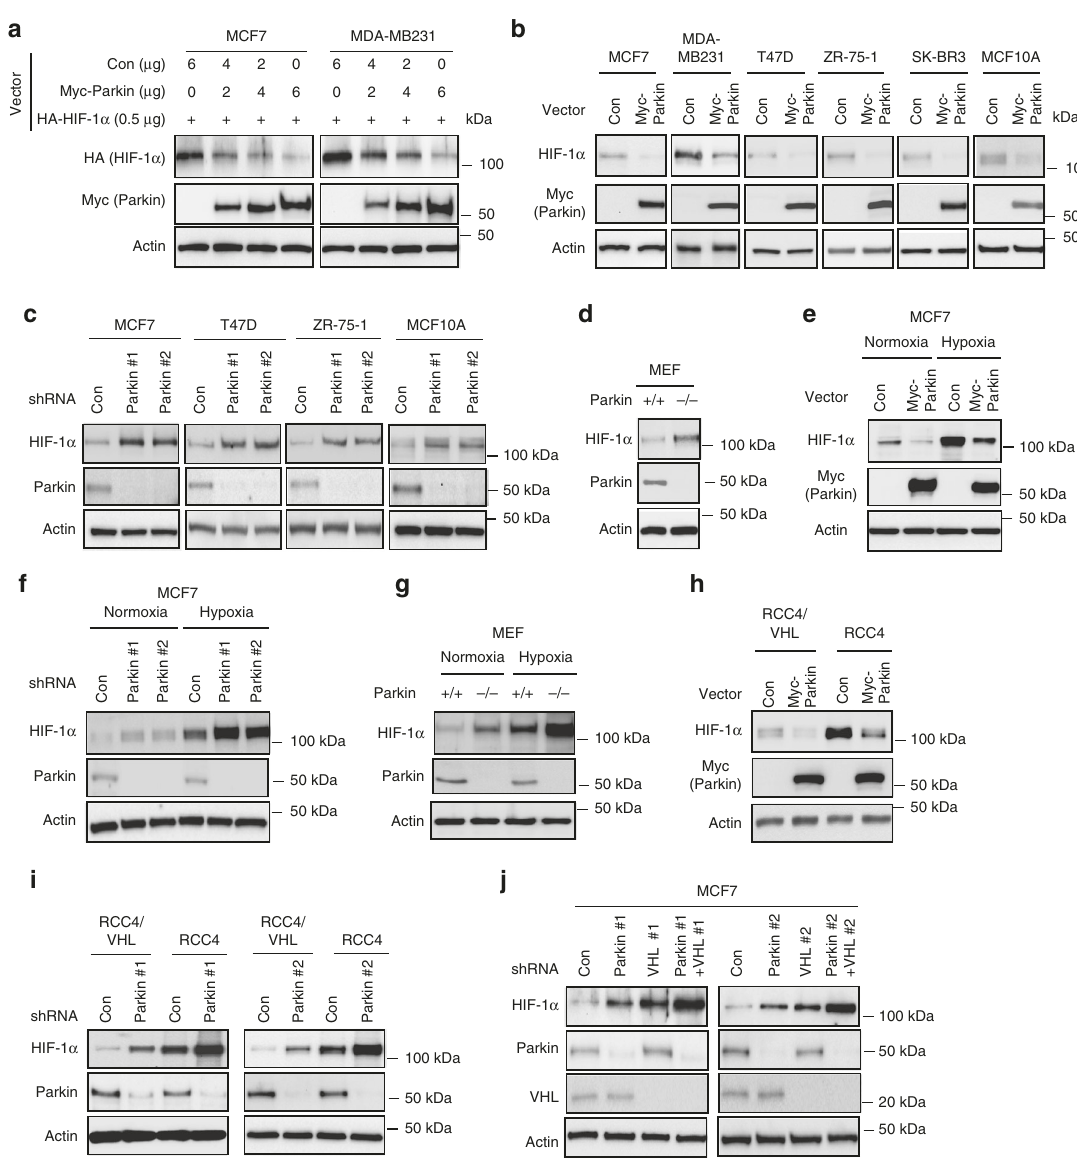
Fig. 2 Parkin negatively regulates HIF-1 α protein levels in cells. a Myc-Parkin expression reduced levels of exogenous HA-HIF-1 α protein in MCF7 and MDA-MB231 cells. Cells were transfected with the HA-HIF-1 α vector together with varying amounts of Myc-Parkin or empty control (Con) vectors. b Ectopic Myc-Parkin expression reduced levels of endogenous HIF-1 α protein in different human breast cells. c Knockdown of endogenous Parkin by 2 different shRNA vectors increased levels of endogenous HIF-1 α protein in different human breast cells. d HIF-1 α protein levels were higher in Parkin − / − MEFs compared with Parkin + / + MEFs. e Myc-Parkin expression downregulated HIF-1 α protein levels in MCF7 cells under both normoxic (20% O 2 ) and hypoxic (1% O 2 ) conditions. f Knockdown of Parkin increased HIF-1 α protein levels in MCF7 cells under both normoxic and hypoxic conditions. g Higher HIF-1 α protein levels in Parkin − / − MEFs than Parkin + / + MEFs under both normoxic and hypoxic conditions. h Myc-Parkin expression reduced the levels of endogenous HIF-1 α protein in both VHL-de fi cient RCC4 cells and VHL-pro fi cient RCC4/VHL cells. i Knockdown of Parkin increased HIF-1 α protein levels in both RCC4 and RCC4/VHL cells. j Knockdown of Parkin in MCF7 cells with VHL knockdown further increased HIF-1 α protein